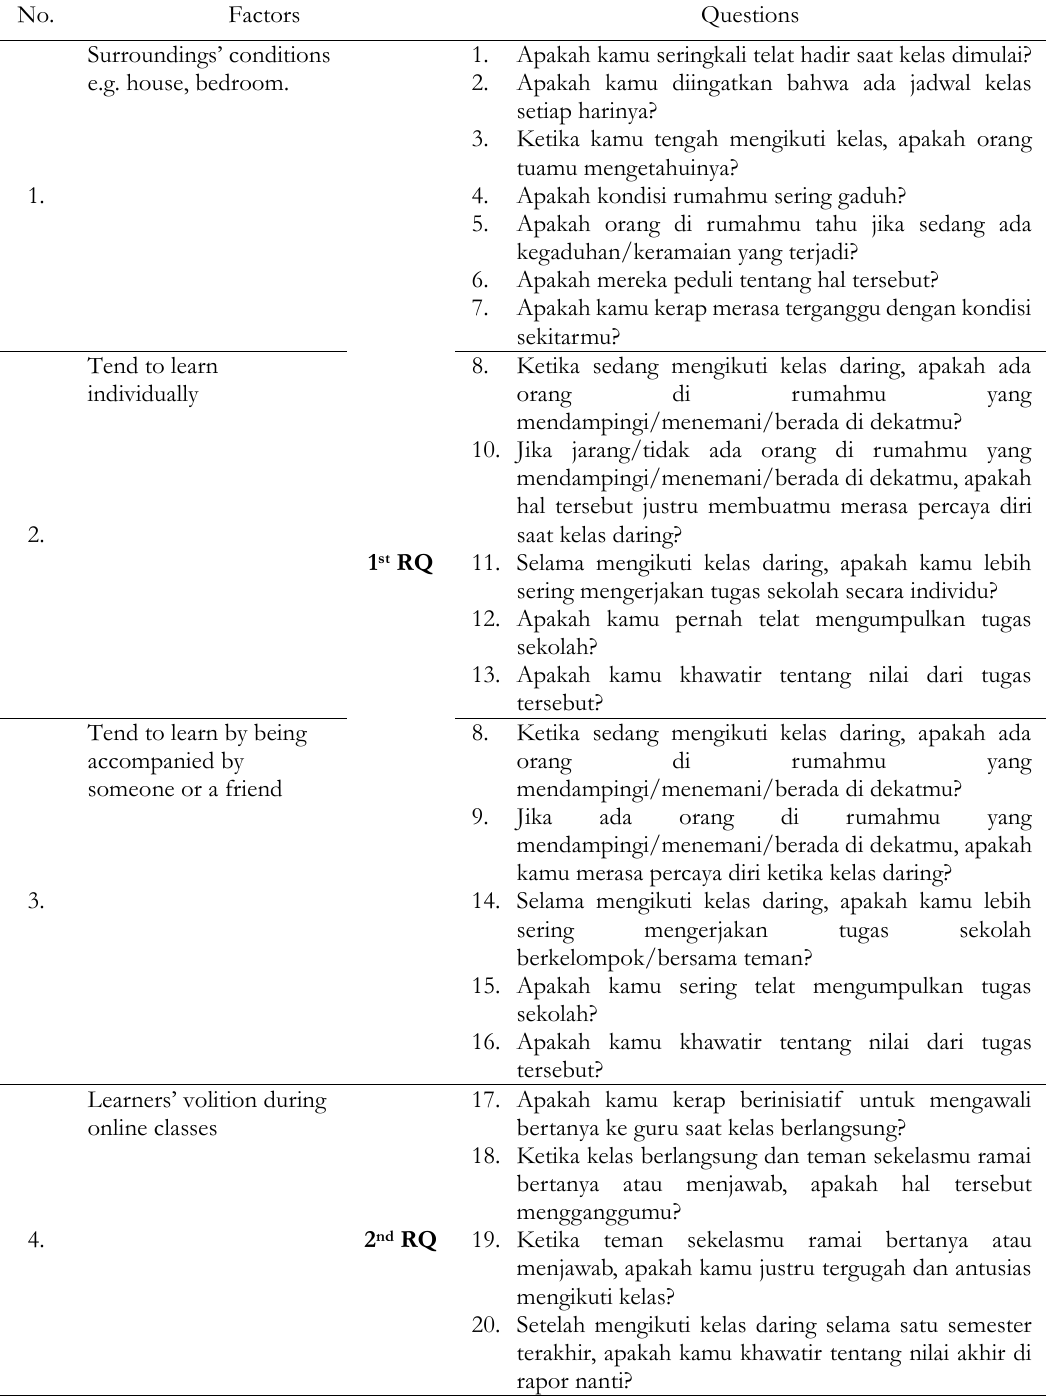
TABLE 1. List of Questionnaire’s